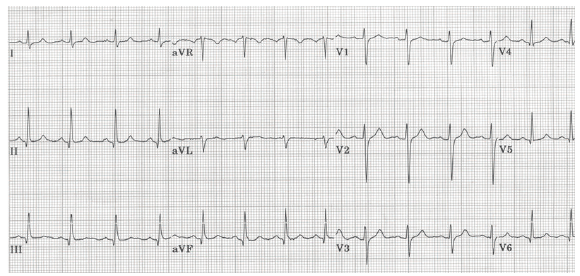
Figure 1: ECG during pain crisis.